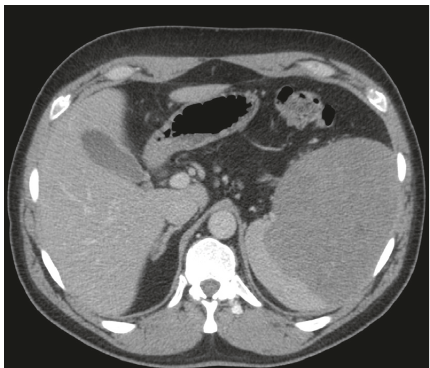
Figure 2: Abdominal CT scan performed before the surgery. Significant spleen enlargement is visible with distinctive area of parenchyma affected by the angiosarcoma.